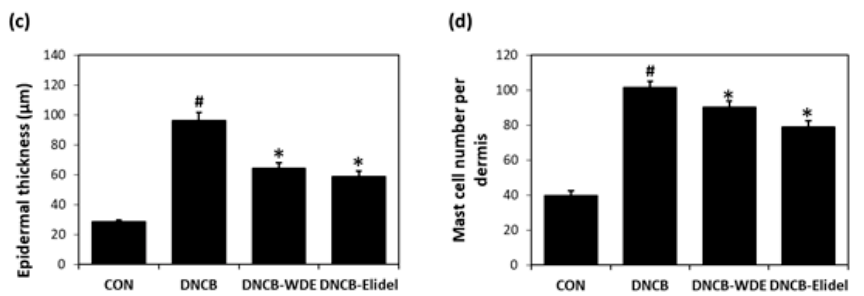
Figure 4. E ff ects of WDE on histopathological changes, epidermal thicknesses, and mast cell numbers on DNCB-induced AD-like symptoms in SKH-1 hairless mice. ( a ) H&E staining. ( b ) Toluidine